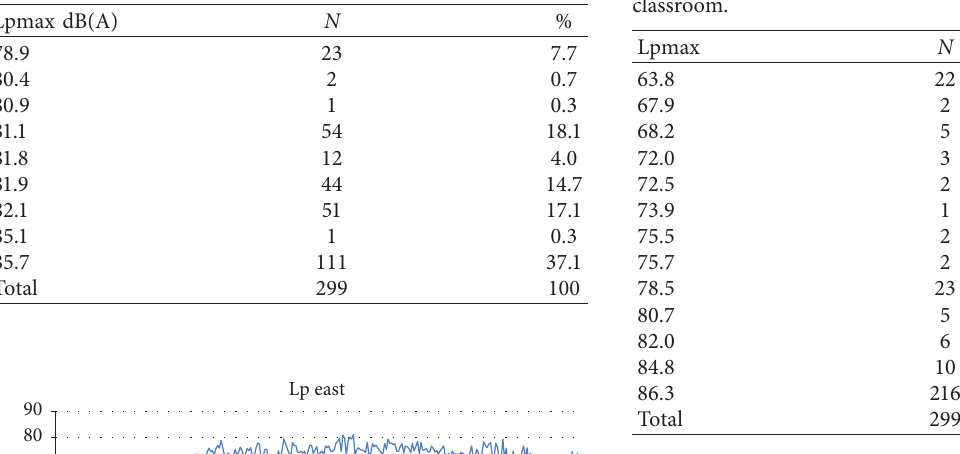
Figure 4: Sound level Lp west of the practical classroom. Table 3: Maximum sound level Lpmax west of the